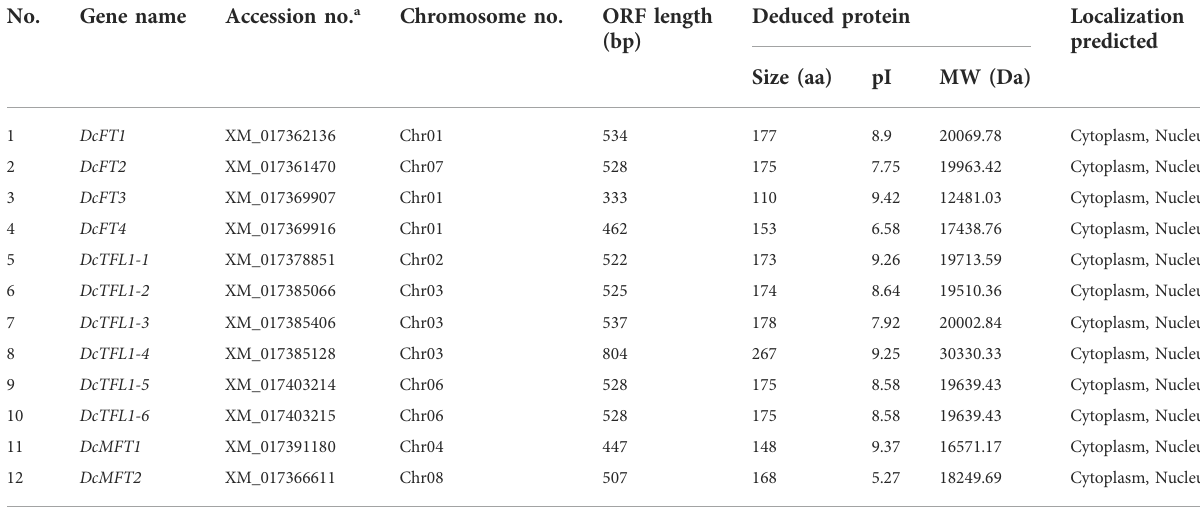
TABLE 1 List of the 12 PEBP family genes in